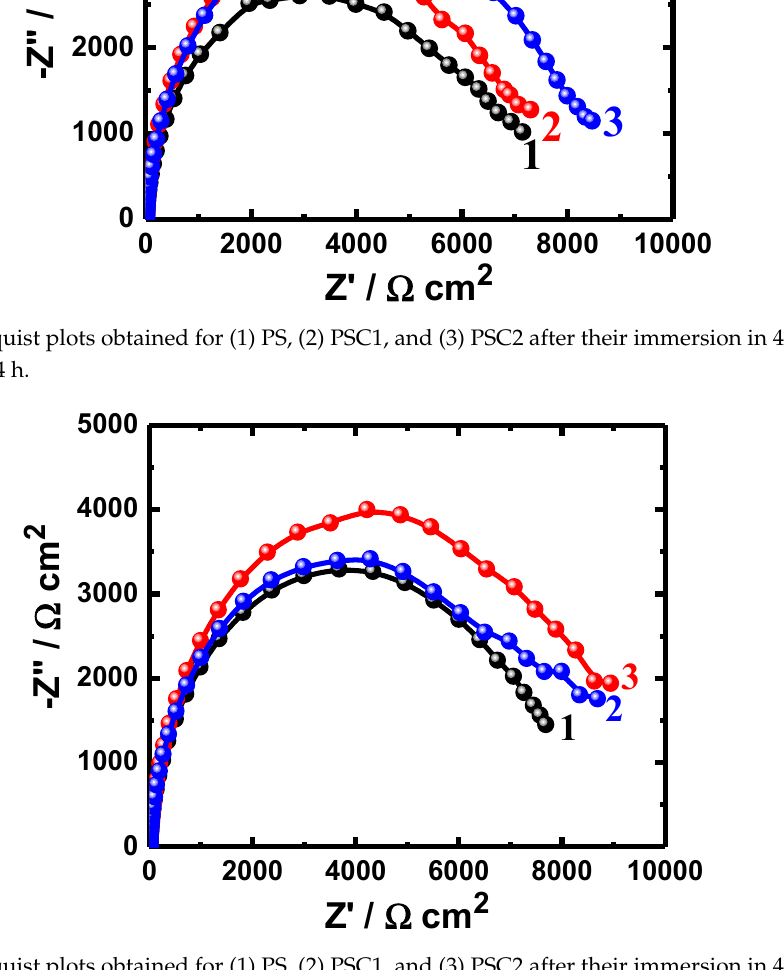
Table 3. EIS data obtained for the uncoated and coated steel samples after different immersion periods in 4% NaCl solution.